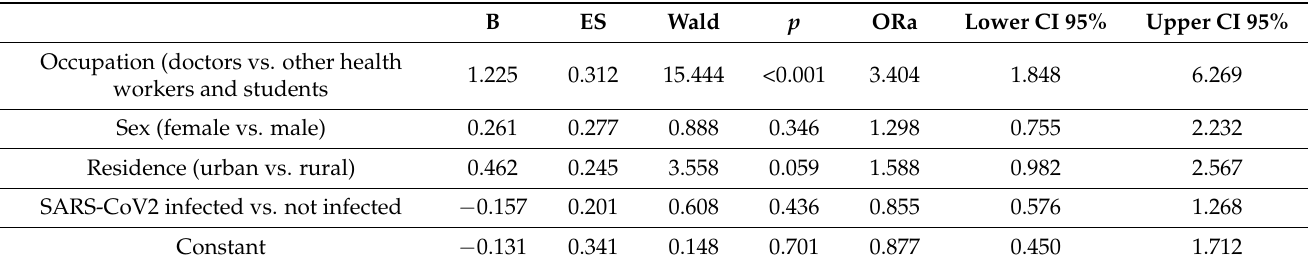
Table 4. Logistic regression model for COVID-19 vaccine